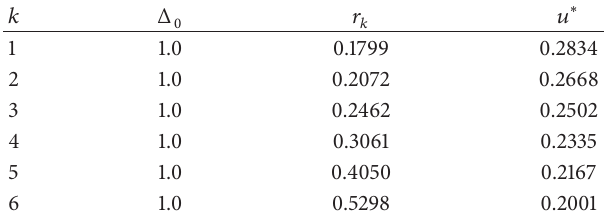
Table 3: Result of fault parameter